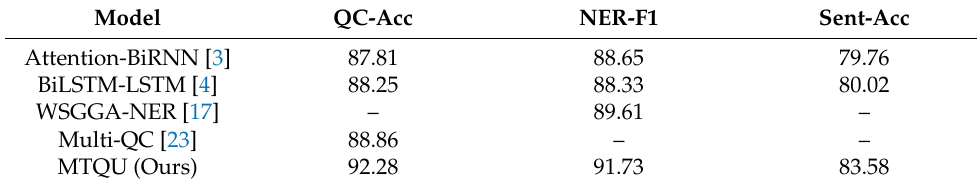
Table 3. Comparison with published approaches.